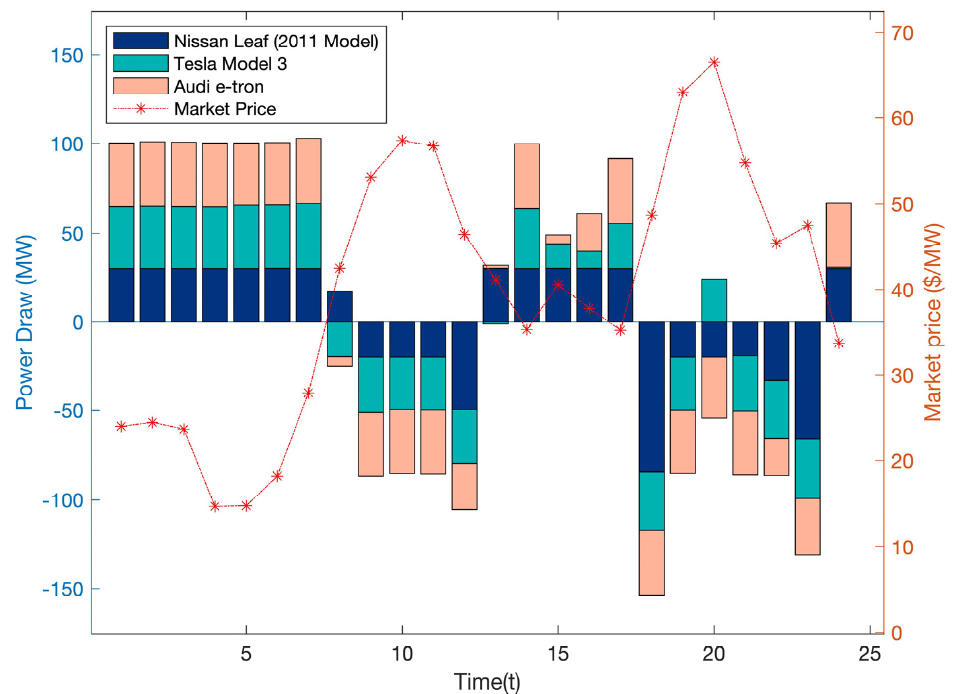
Figure 3. Result of different operating point under 3 different kinds of electric vehicle (EV) in bi-level